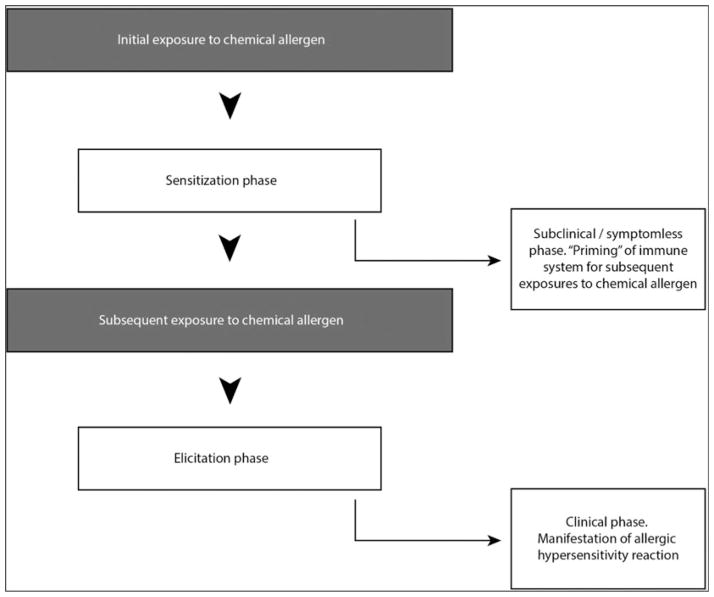
Illustration of the development of allergic sensitization and diseases associated with chemical allergens. Illustration of a simplified description of the onset of allergic sensitization and diseases associated with chemical allergens. In the first phase, sensitization of a naïve individual occurs following an initial encounter with a chemical allergen that results in an adaptive immune response that primes the immune system for future exposures. This is a subclinical phase that is symptomless. Subsequent exposures to the chemical allergen trigger the clinical phase, referred to as elicitation, which manifests as allergic hypersensitivity reactions such as asthma, rhinitis, and allergic contact dermatitis.